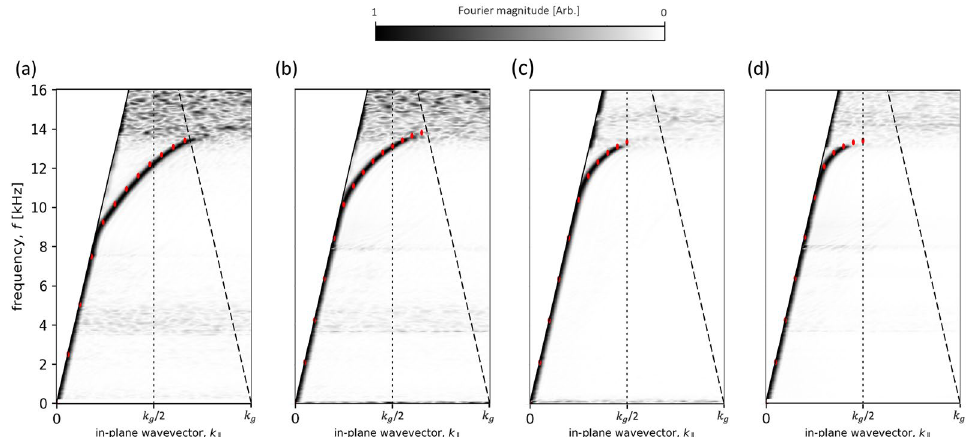
Figure 5. Dispersion diagrams calculated from experimental data for the sample in the glide-symmetric arrangement, at different separations along the z axis. ( a ) h = 1.5 mm, ( b ) h = 3 mm, ( c ) h = 5 mm and ( d ) h = 10 mm. Absolute Fourier amplitude is shown as a function of frequency and in-plane wavevector k (cid:31) with the colour representing the Fourier amplitude. Data is normalised using slices in frequency. Solid black lines represent the sound-line ( k 0 ) and dashed black lines the diffracted sound-lines with vertical dotted lines indicating the first BZB at k (cid:31) = k g / 2 . Red points show eigenfrequency predictions from a loss-inclusive numerical